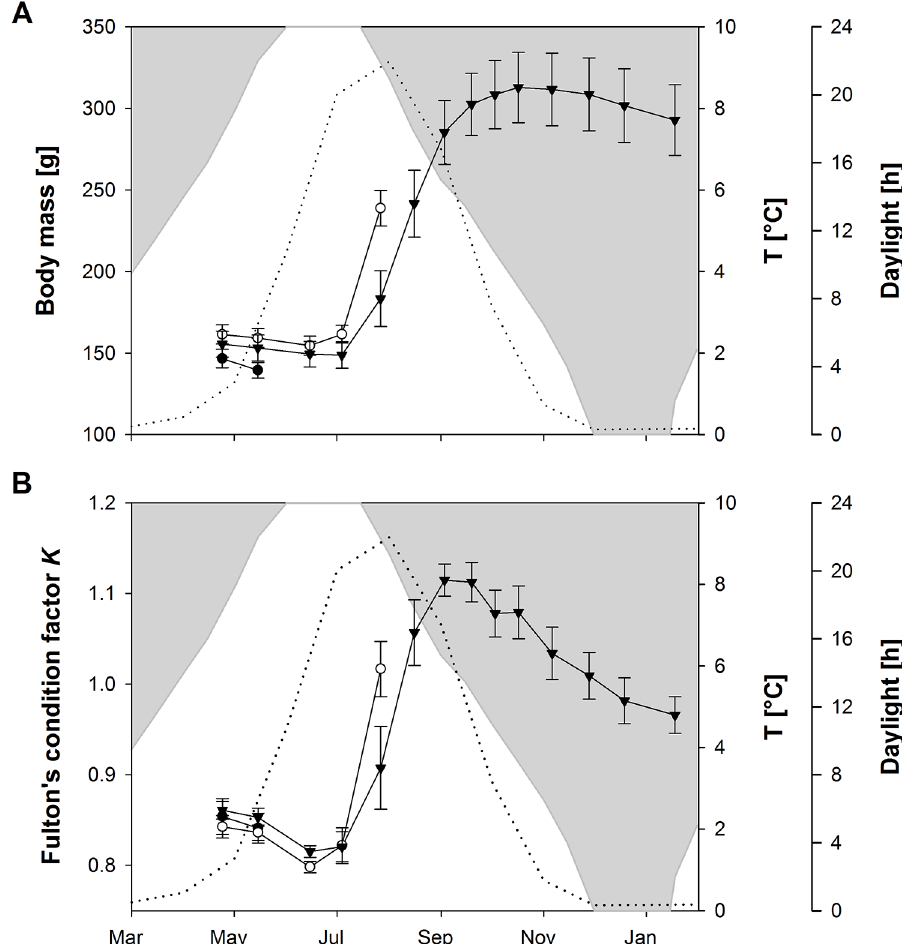
Fig 1. Body mass development (A) and Fulton ’ s Condition Factor K (B) of the fish sampled for mRNA quantification. Black dots: Sampled in May 2012, White dots: Sampled in July 2012, Triangles: Sampled in January 2013. Data are presented as mean (n = 10) ± s.e.m. Dotted line: temperature profile. White area: hours of